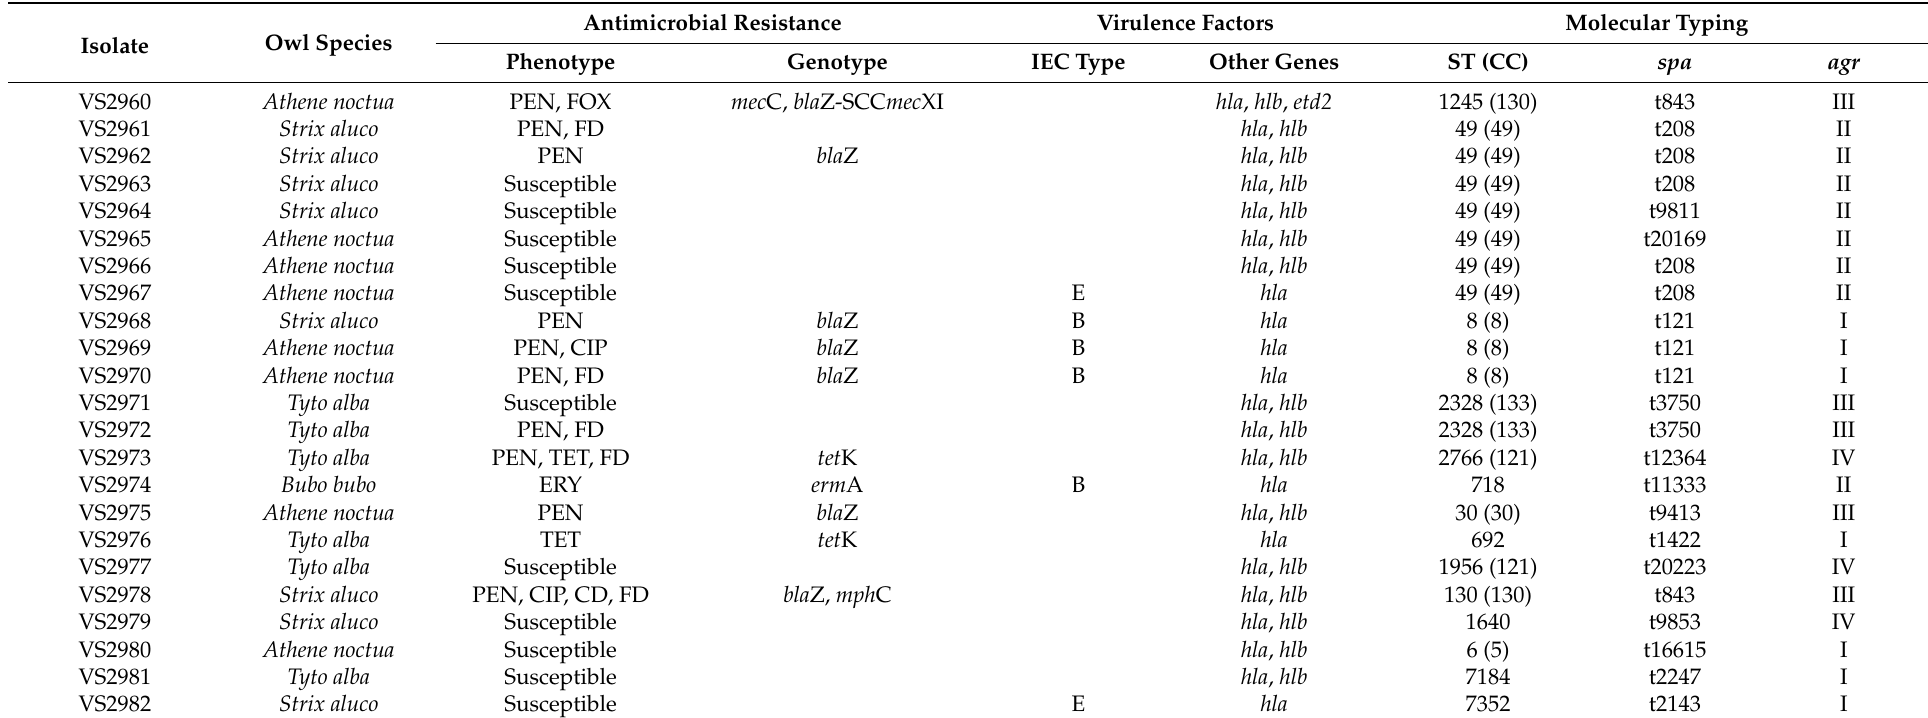
Table 2. Genetic characterization and molecular typing of MRSA and MSSA isolates recovered from wild